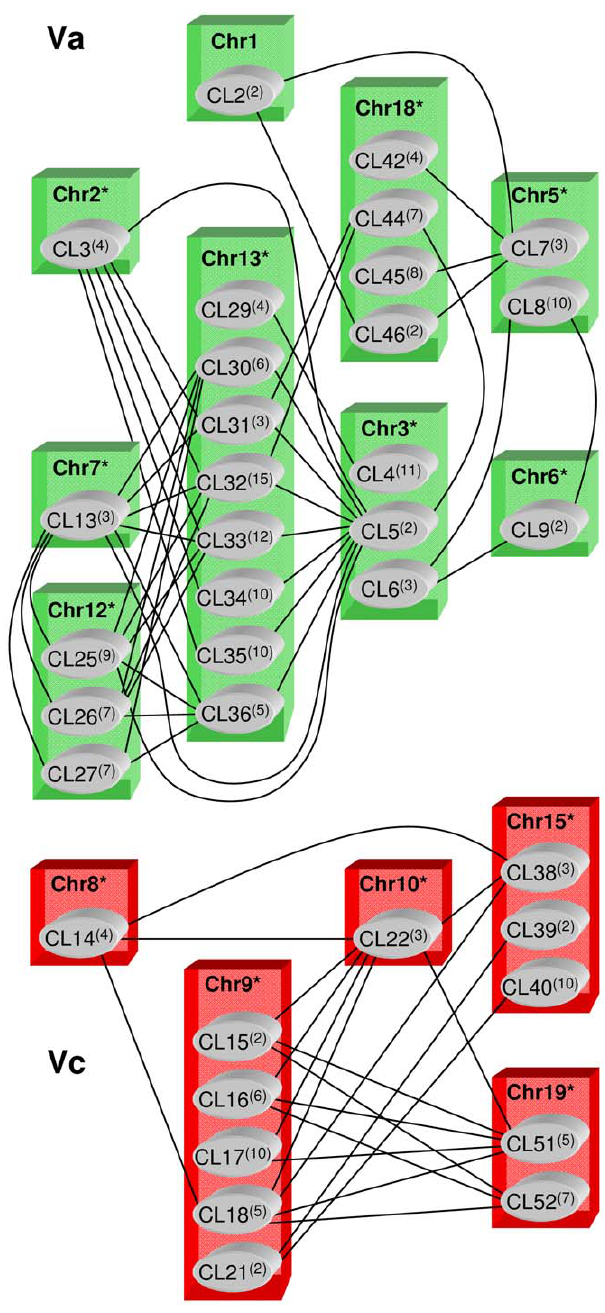
Figure 1. Grapevine chromosome groups based on NBS - R gene- to-gene similarities. Relationships (indicated by joining lines) between grapevine chromosomes based on the 93rd percentile of the distribution of among-clusters BLAST bit scores generated by a pairwise BLAST-P protein sequence comparison. Va (green) and Vc (red) define two genomes based on the chromosome groups indicated. Chromosomes that were also associated with Va or Vc genomes based on the identity scores are highlighted by an asterisk. NBS - R gene clusters (CL) are indicated within gray circles with the number of NBS - R genes in